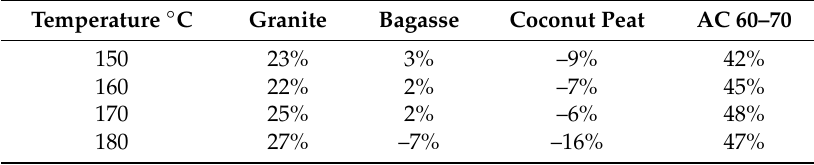
Table 4. The sensitivity of viscosities relative to asphalt mastic with limestone